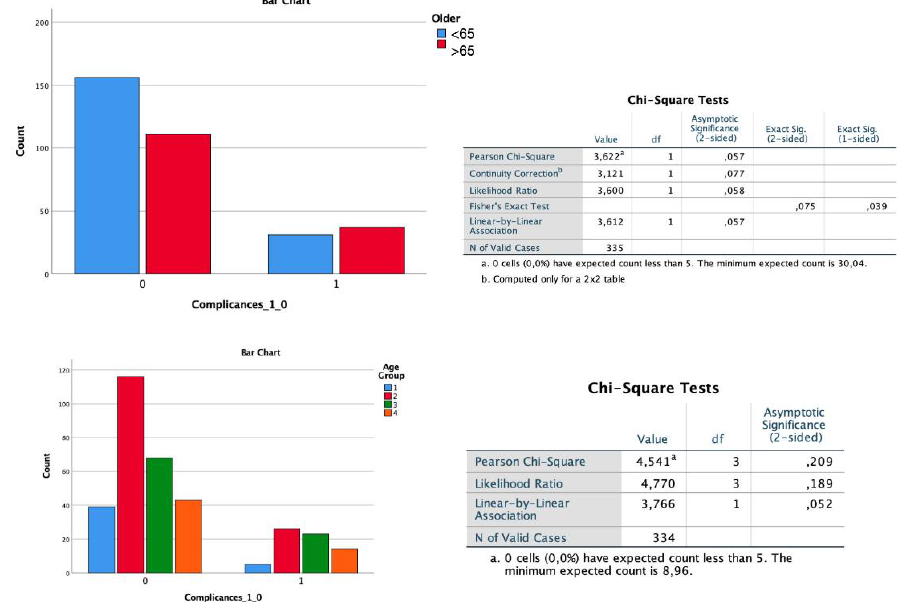
Figure 6. Analysis of complications with chi-square testing does not document the presence of an increased number of complications in the postoperative phase of young patients compared with the elderly (Figure 5), nor does it identify one type of complication as more frequent than another (Fig- ure 6).